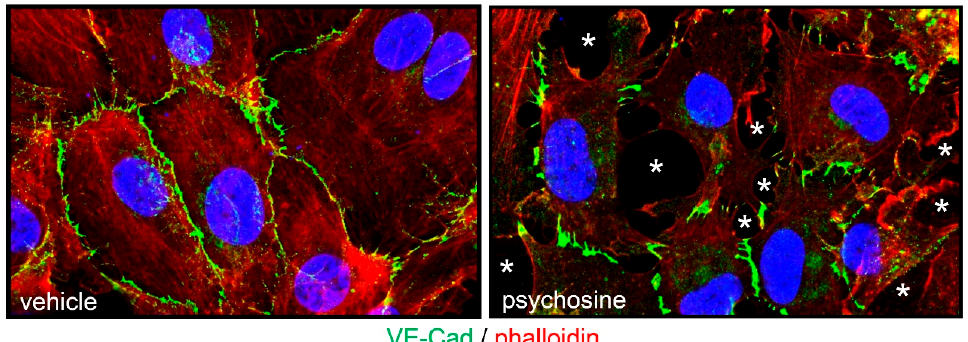
Figure 7. Psychosine affects the endothelial barrier integrity. HUVEC monolayer were treated overnight with 50 μ M psychosine and immunostained with an anti-VE-Cad antibody (in green). Actin cytoskeleton was visualized by incubation with rhodamine phalloidin (in red) and nuclei were counterstained with DAPI (in blue). Note the loss of junctional protein organization and the appearance of endothelial gaps (asterisks) in the psychosine-treated HUVEC monolayer.